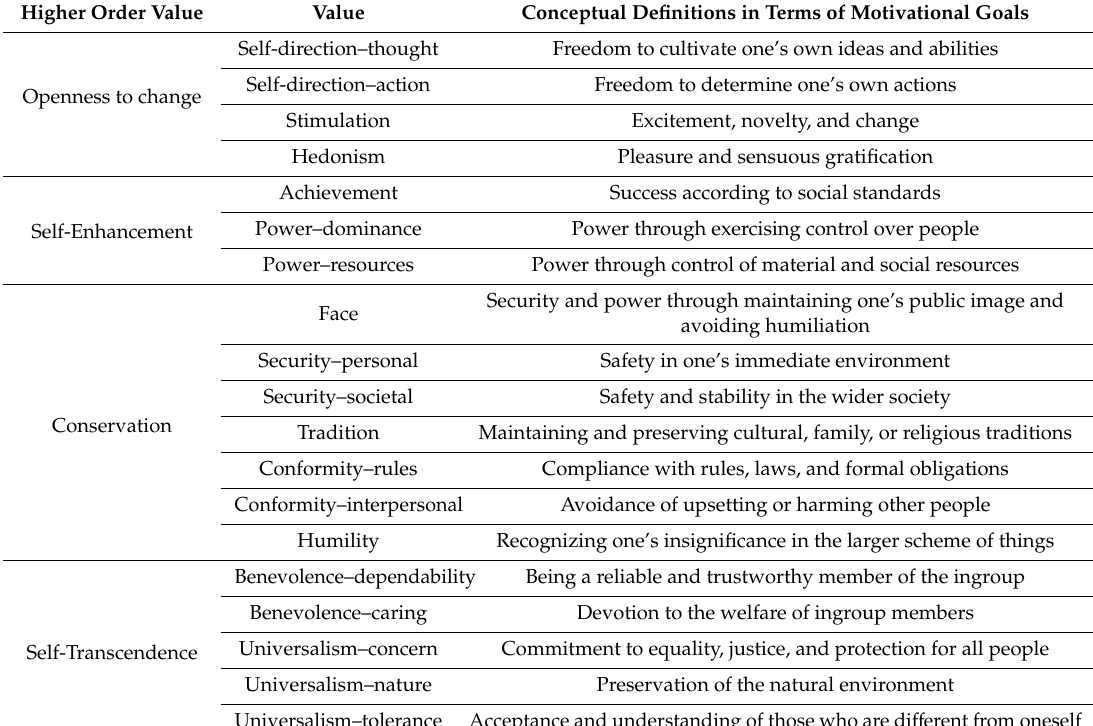
Table 1. The 19 values and 4 higher order values and their conceptual definitions adapted from Reference